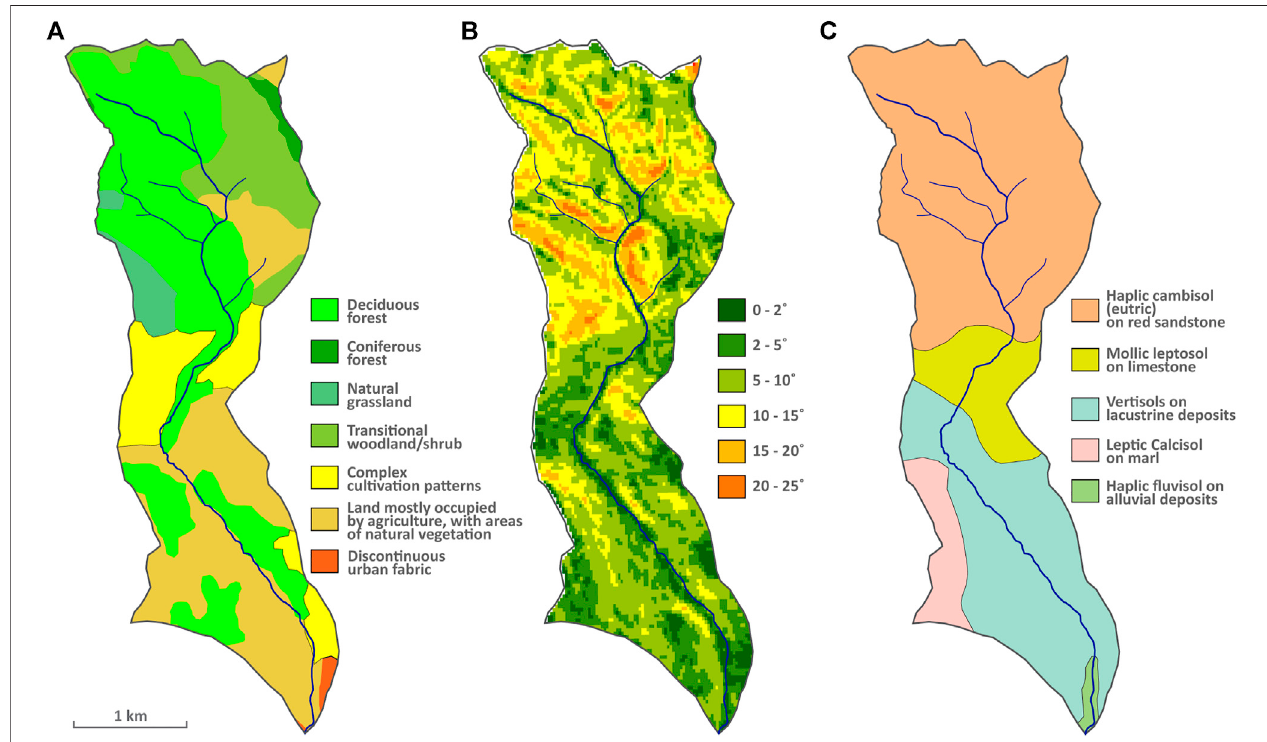
FIGURE 2 | (A) Land Cover (B) slope and (C) soil map of the Crveni potok River